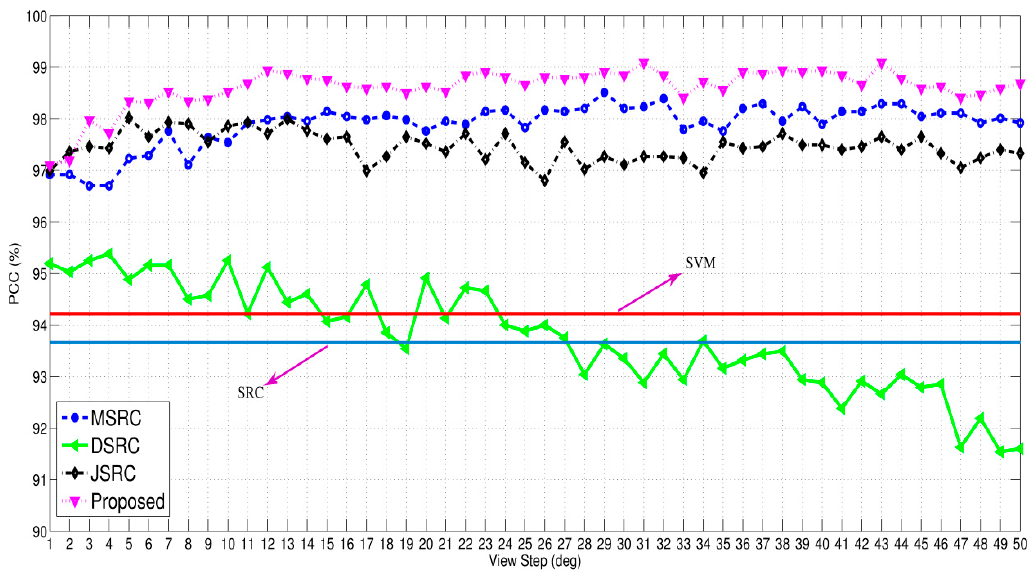
Figure 6. The PCCs of multi-view methods at fixed view steps. Table 6. PCCs of multi-view methods under unstable azimuth separations.